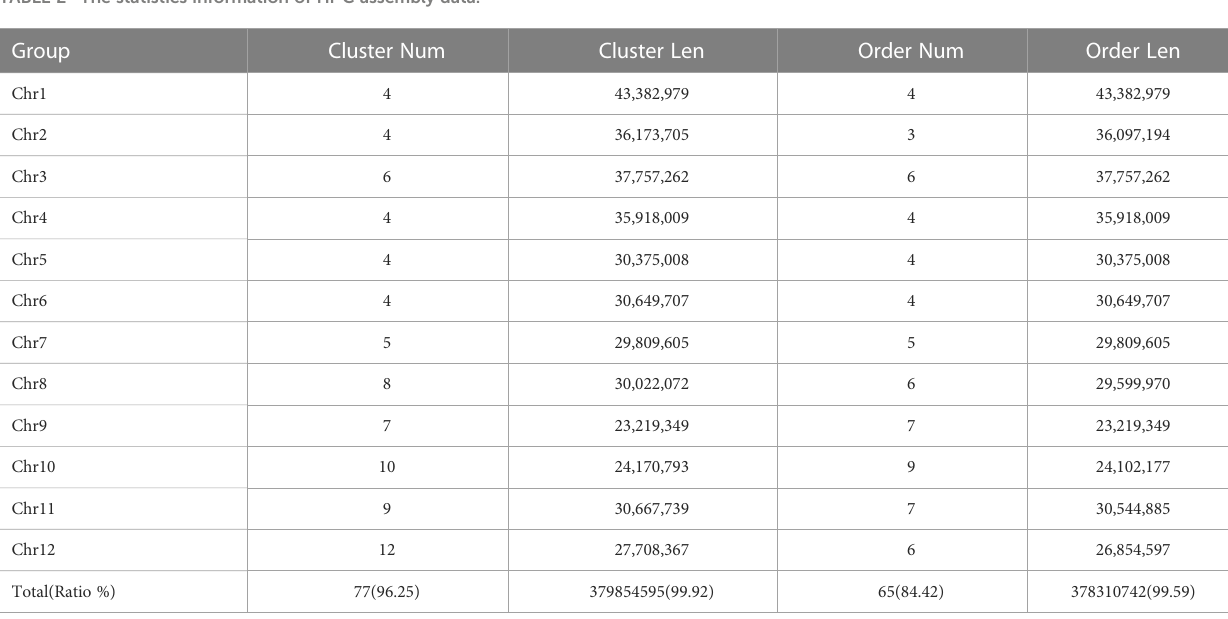
TABLE 2 The statistics information of Hi-C assembly